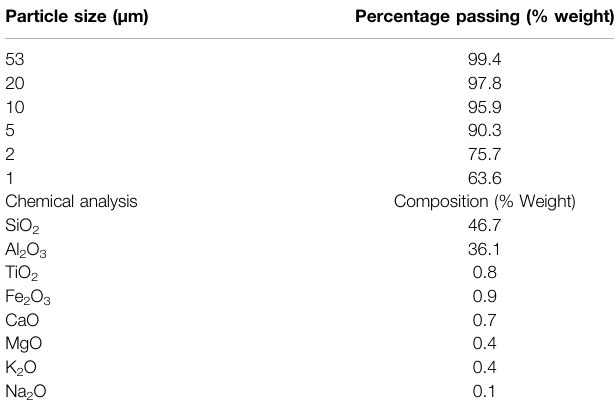
TABLE 2 | Particle size distribution and chemical composition of the